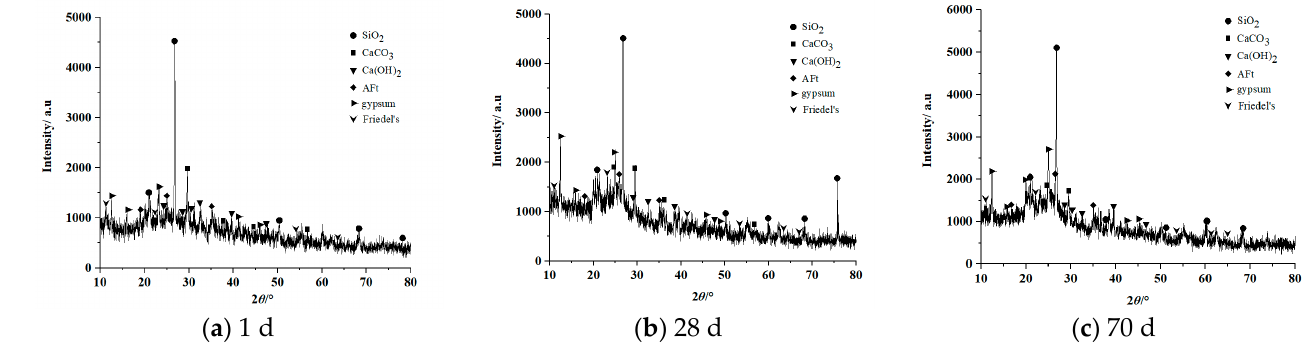
Figure 8. XRD patterns of T5 specimen at 1 d, 28 d, and 70 d.